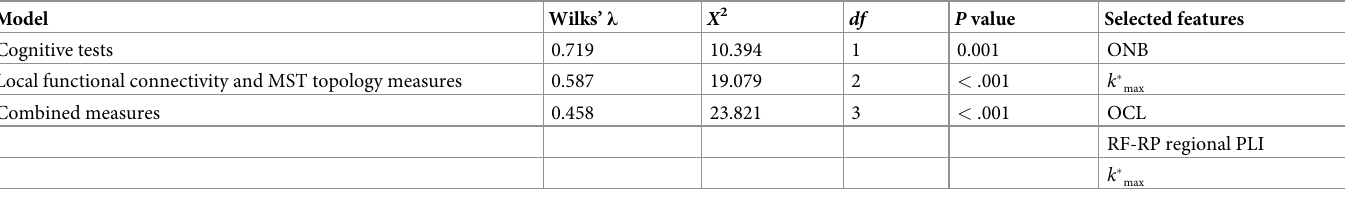
Table 6. Wilks’ λ and selected features of linear discriminant analyses.